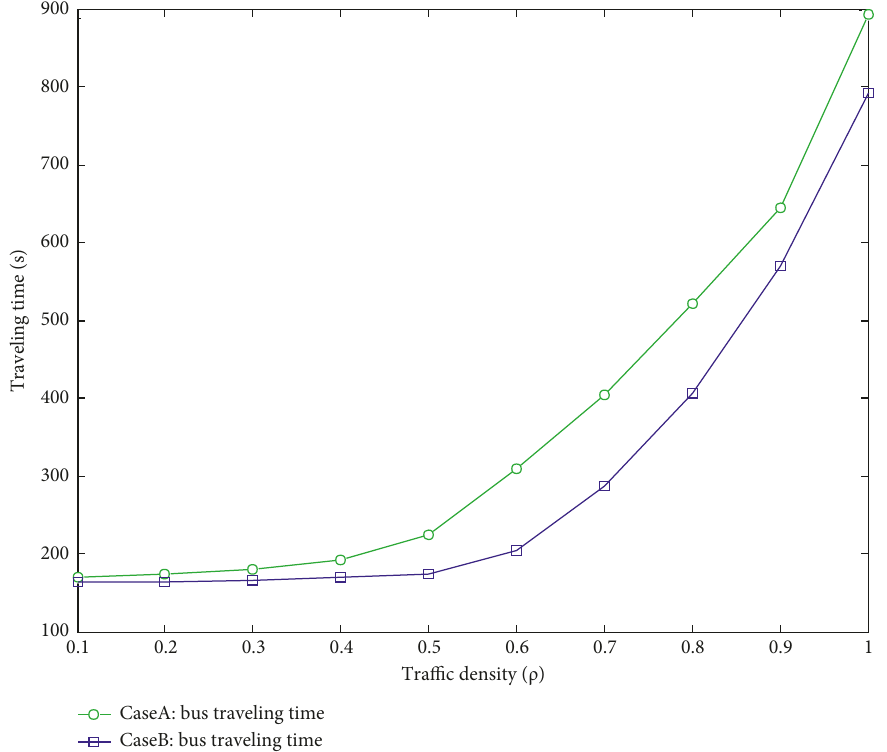
Figure 5: Average bus travel time in Group A and Group B given traffic